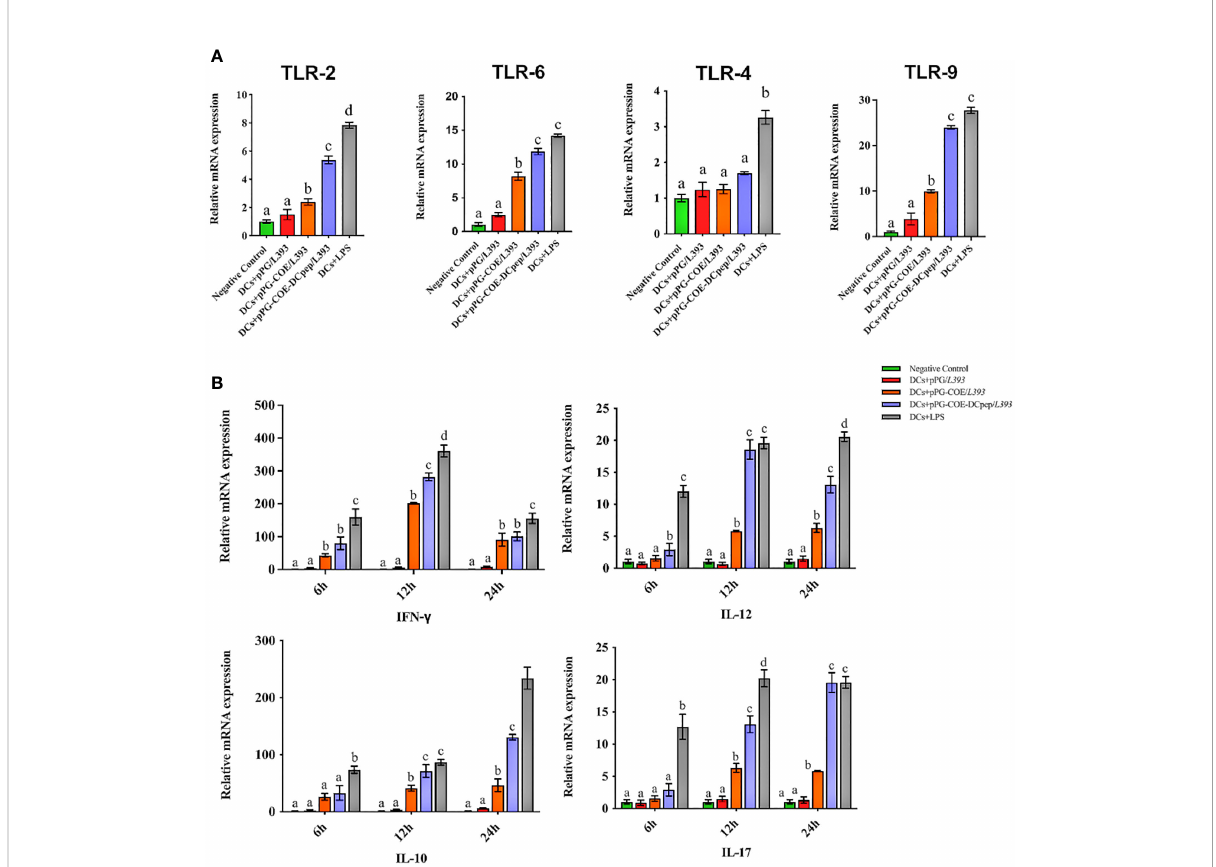
FIGURE 5 Analysis of toll-like receptor (A) and cytokine (B) mRNA levels in Mo-DCs (10 6 cells/ mL) in response to pPG/ L393 , pPG-COE/ L393 , pPG-COE- DCpep/ L393 , and LPS (2 µg/mL) stimulation; recombinant Lactobacillus -incubated DCs at a ratio of 1:10 (DCs: recombinant Lactobacillus ). Mo- DCs were stimulated by recombinant Lactobacillus and LPS for 6, 12, or 24 h. Unstimulated Mo-DCs were used as a control. Different letters (a vs. b, a vs. c, b vs. c) indicate signi fi cant differences (p < 0.01) at the same time